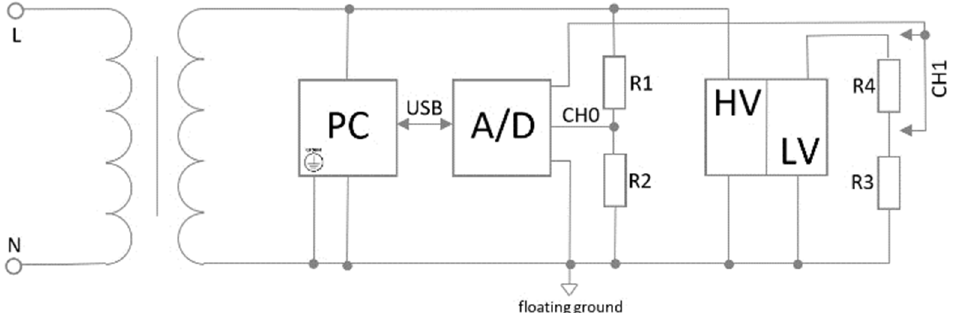
Figure 8. The wiring diagram of the measuring apparatus. The Live (L) and Neutral (N) contacts of mains are connected to the primary winding of the isolation transformer. One of the outputs of the isolation transformer secondary winding is selected as a common floating ground for grounding the PC, A/D converter, high-voltage (HV) and low-voltage (LV) sides of the fixtures and resistive dividers. If the maximum output voltage from the fixture was higher than the range of the AD converter, the signal for CH1 was sensed at the voltage divider (R3, R4).